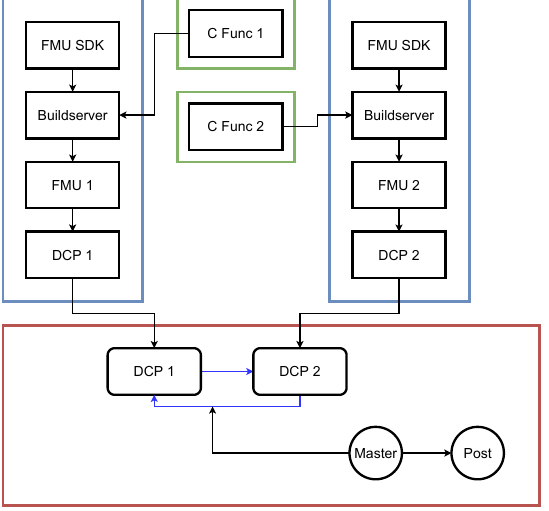
Figure 6. Schematics of a simple build and simulation